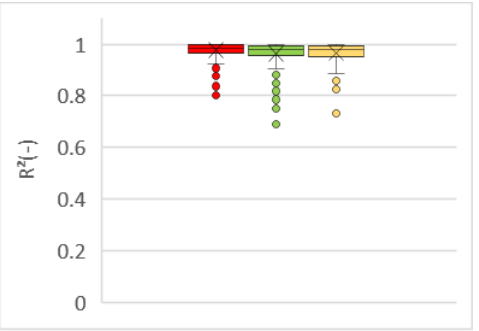
Figure 7. Box plots of the R 2 of the validation chromatograms with predicted parameters over the chromatograms with the original parameters. The red box plot represents IgG, green represents HCP1 and yellow represents HCP2.